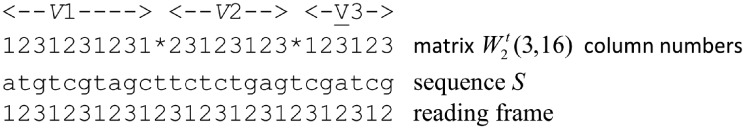
Scheme of division of mFmax on V1, V2 and V3 (see Section 2.4).